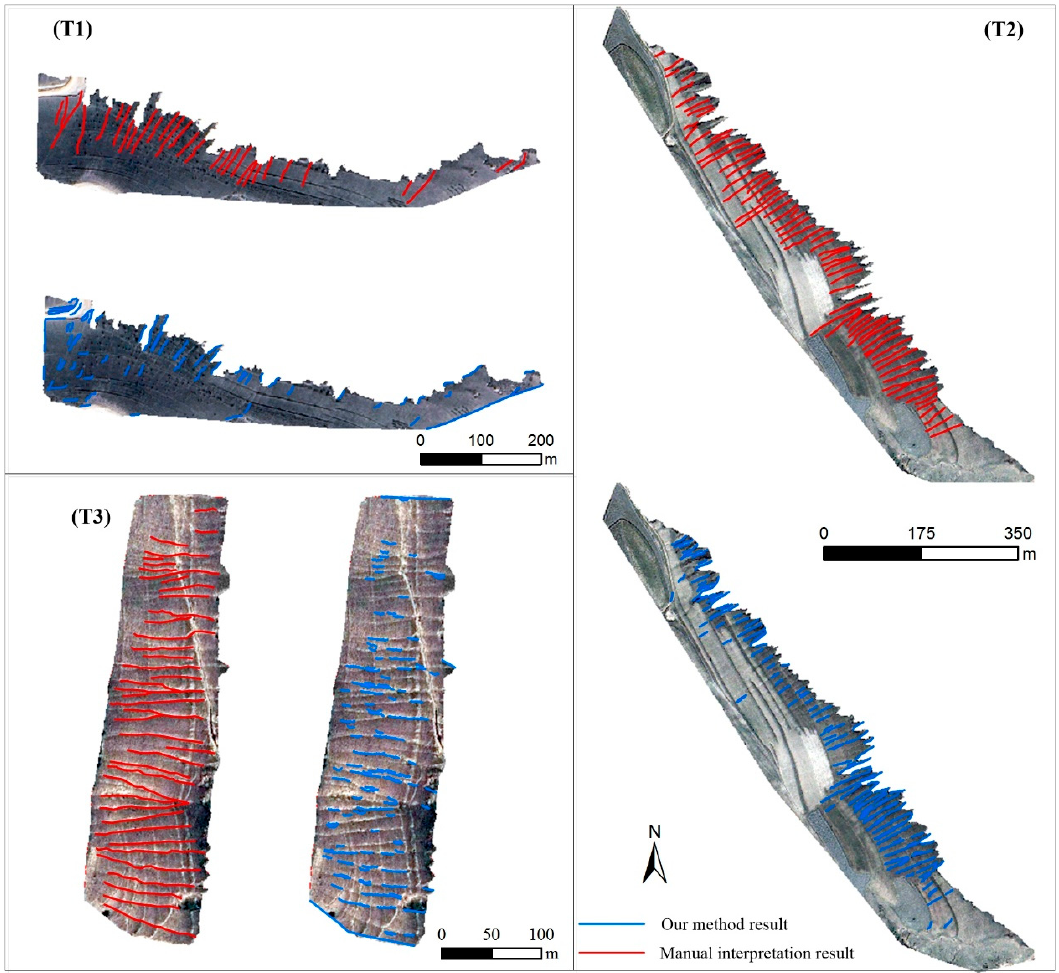
Figure 10. Extracted results of ephemeral gullies and their comparison with manual interpretation results : ( T1 ) result in Jingbian area; ( T2 ) result in Dingbian area; and ( T3 ) result in Huanxian area.